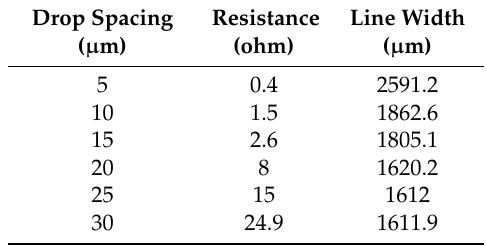
Table 1. Line width and resistance at different DS.